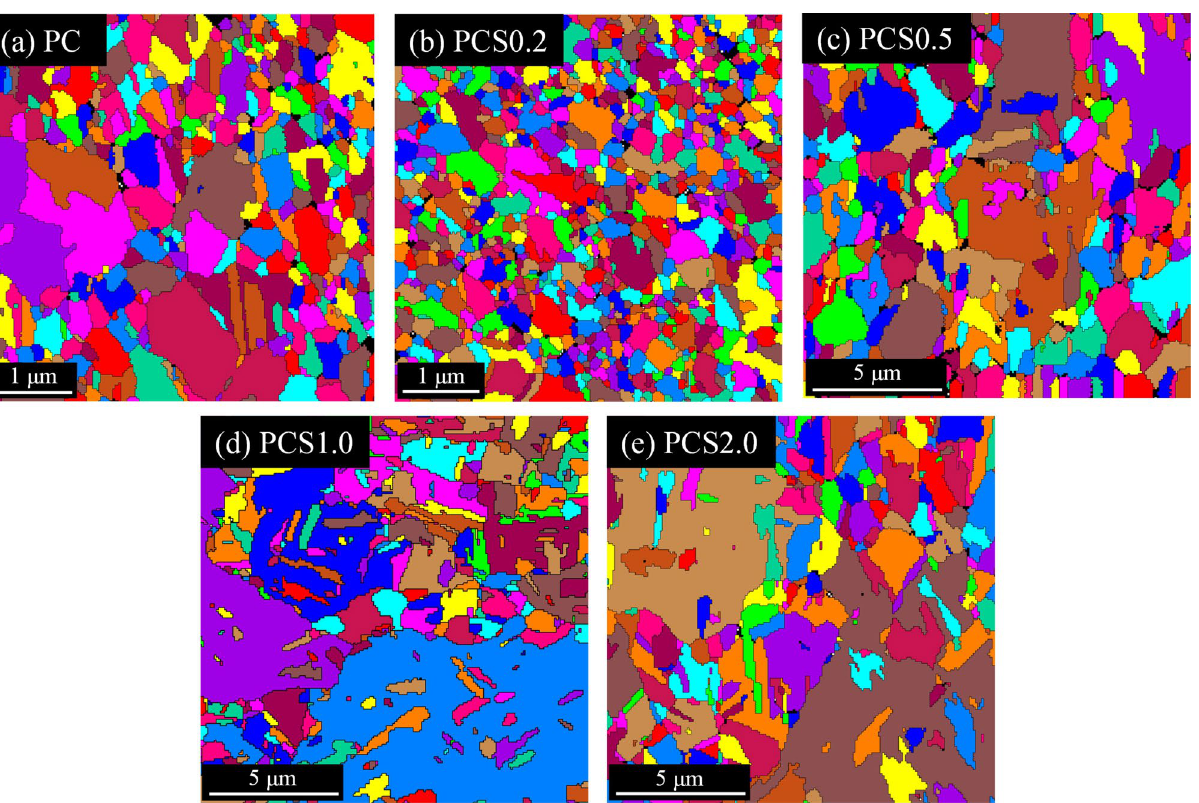
Figure 5. EBSD grain mappings of the Cu electroplated layers labelled as ( a ) PC, ( b ) PCS0.2, ( c ) PCS0.5, ( d ) PCS1.0, and ( e ) PCS2.0. The mappings are created by OIM Analysis v8 (https:// www. edax. com/ produ cts/ ebsd/ oim- analy